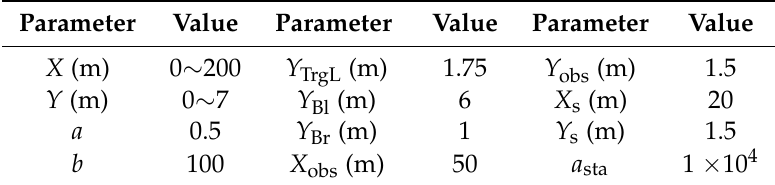
Table 1. Parameters for PF construction.